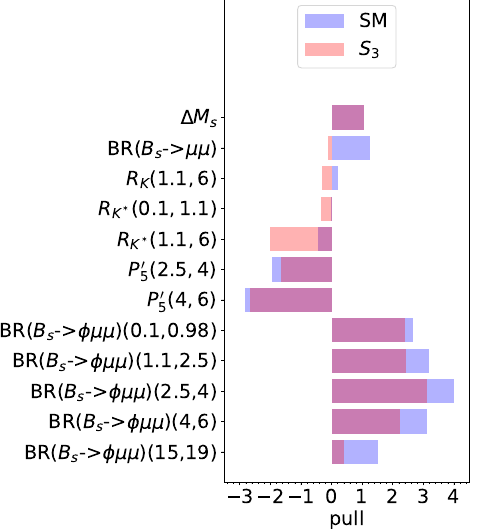
Figure 5 . Pulls of some observables of interest for best-fit points of the S 3 leptoquark model at M S = 3 TeV and the B 3 − L 2 Z 0 model best-fit point at M Z 0 = 3 TeV. The pull is defined in (4.3). 3 Numbers in parenthesis denote the domain of the di-lepton invariant mass-squared bin, in GeV 2 . The best-fit parameters for the leptoquark model are λ = 1 . 3 , θ 23 = − 0 . 000467 . For the Z 0 model, they are g Z 0 = 0 . 239 , θ 23 = − 0 . 0133